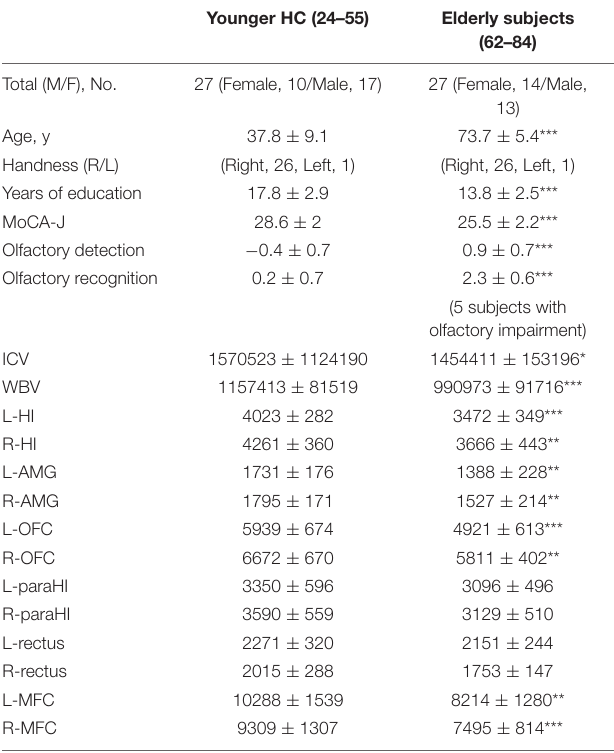
TABLE 1 | Demographic data of young healthy controls and elderly subjects. Younger HC